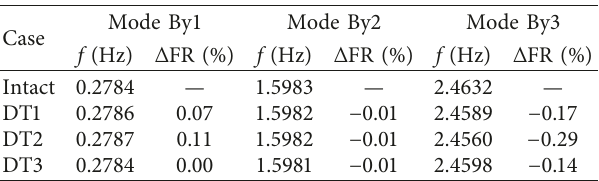
Table 10: Natural frequencies of across-wave bending modes: damage type